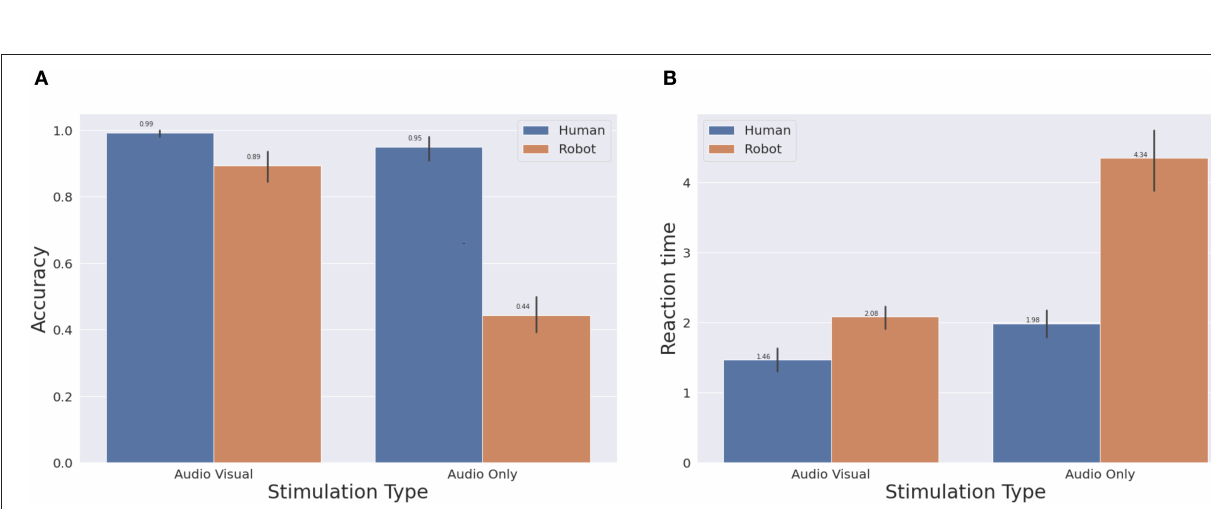
Frontiers in Neurorobotics | www.frontiersin.org